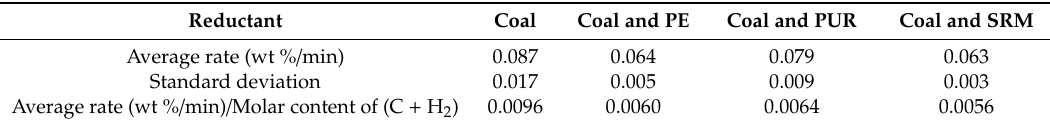
Table 3. Average Zn reduction rates and standard deviations.